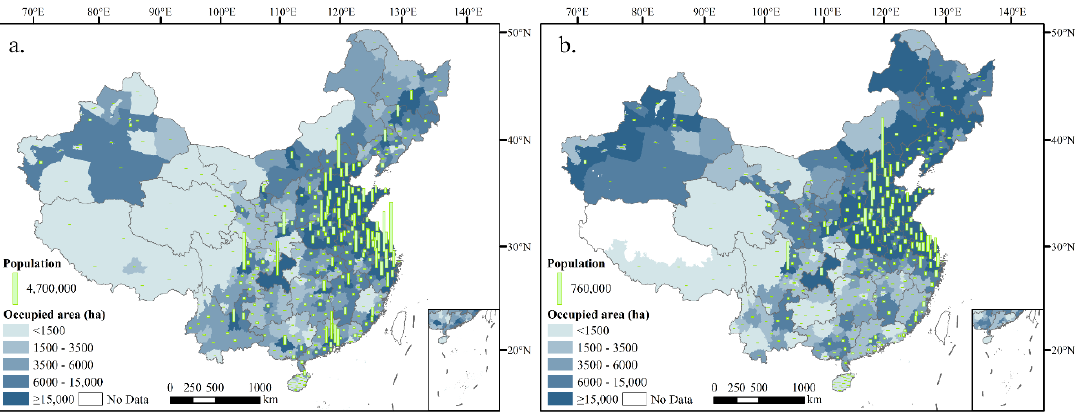
Figure 2. Cultivated land area occupied by urban (a) and rural (b) construction land and the population it carries in China from 1990 to 2020.